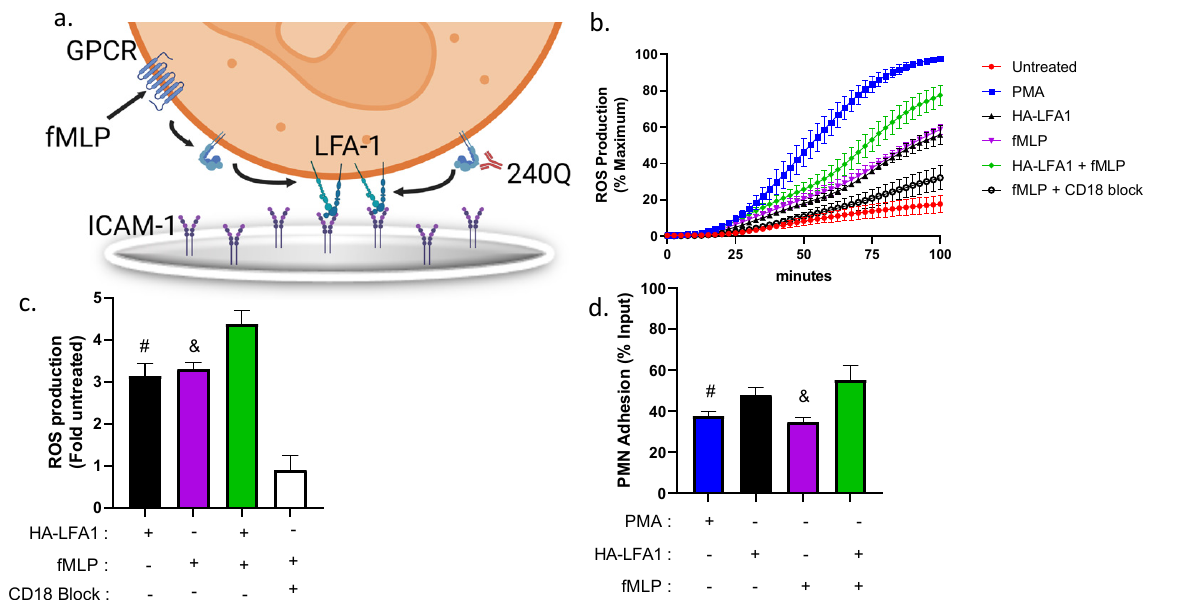
Figure 4. Mechanoregulation of superoxide production in neutrophils adherent to ICAM-1. Neu- trophils were allowed to adhere to the substrate of 96 well plates coated with ICAM-1 in the presence of 240Q, fMLP, or both, and the dynamics of intracellular reactive oxygen species (ROS) were measured in a population of shear-mixed neutrophils by detection of dihydrorhodamine (DHR) in a fluorescence plate reader. ( a ) Schematic of cooperative signaling of neutrophil ROS production by GPCR via fMLP and activation of HA CD18 by 240Q binding to ICAM-1. ( b ) Real-time kinetics of ROS production in DHR buffer for neutrophils shear mixed every 2.5 min and stimulated with PMA or 240Q in the presence and absence of fMLP or blocking of CD18 with IB4. ( c ) Histogram of peak ROS production for the indicated conditions expressed as fold increase from the baseline level reg- istered in untreated neutrophils. All data are represented as mean +/- SEM ( n = 5, # denote signifi- cance comparing HA LFA-1 vs. HA LFA-1 + fMLP, p < 0.05). & denote significance fMLP vs. HA LFA-1 + fMLP, p < 0.01). All conditions significantly greater than CD18 block condition, p < 0.01). ( d ) Neutrophil adhesion measured as fraction of total input remaining at the end of the time course based upon Hoechst fluorescence. All data are represented as mean +/- SEM ( n = 5, # significance comparing PMA vs. HA LFA-1 + fMLP, p < 0.01. & denote significance comparing fMLP vs. HA LFA-1 + fMLP, p < 0.01).